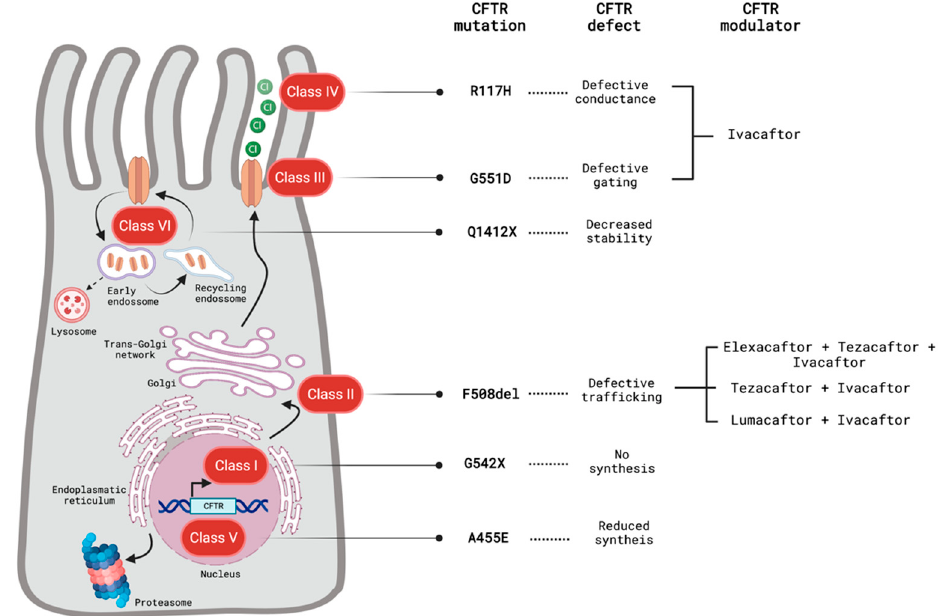
Figure 1. Classification and effects of CFTR mutations and approved CFTR function-restoring pharmacological interventions. Class I mutations result in the premature termination of CFTR transcription and in the absence of a functional CFTR. Class II mutations lead to the misfolding of CFTR protein and aberrant trafficking of the protein. Class III mutations are gating mutations causing ineffective chloride/bicarbonate transport. Mutations belonging to class IV decrease the conduction of ions through the channel. Class III and IV mutations lead to normal levels of CFTR expressed at the cell surface but a reduced CFTR function. Splicing and missense mutations belong to class V and cause reduced CFTR synthesis. Class VI mutations reduce CFTR stability of the cell membrane due to increased CFTR recycling. Thus far, the CFTR modulators in the clinic target class II, class III and IV mutations. Image created using Biorender.com (www.biorender.com; access on 22 November 2022).